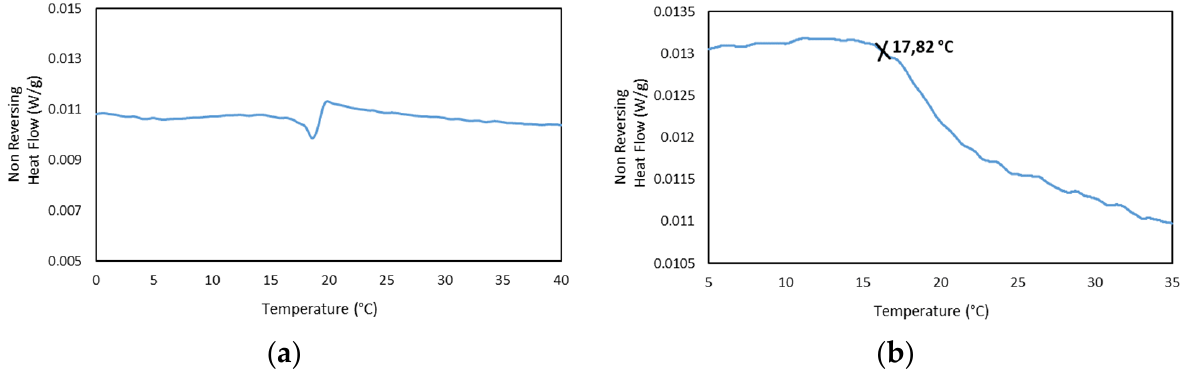
Figure 10. MDSC of 25GE thermogram of the ( a , b ) Non Reversing Heat Flow of the cooling ramp at 0.50 °C/min.